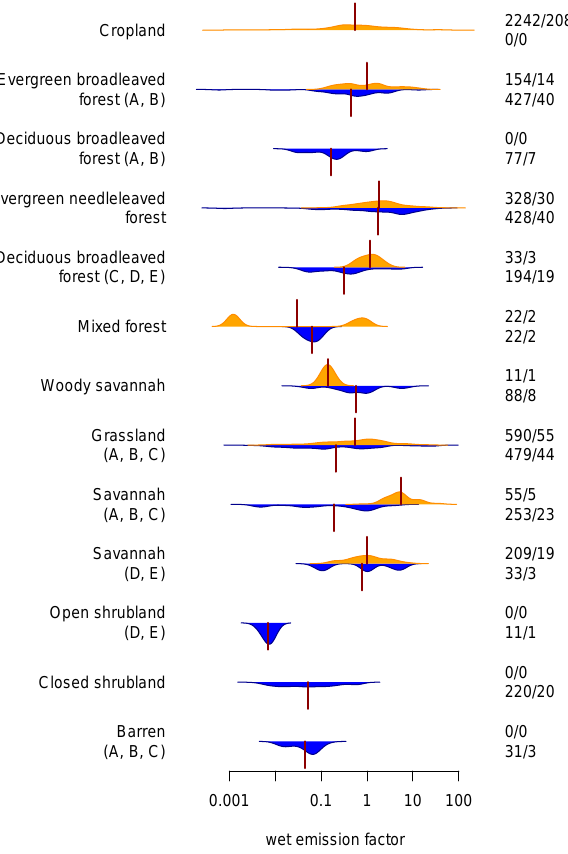
Fig. 8. Distribution of calculated emissions factors for anthro- pogenically altered (orange, above center line) and unperturbed (blue, below center line) measurements. The number of calculated emission factors and number of measurements per crop are given on the right side,